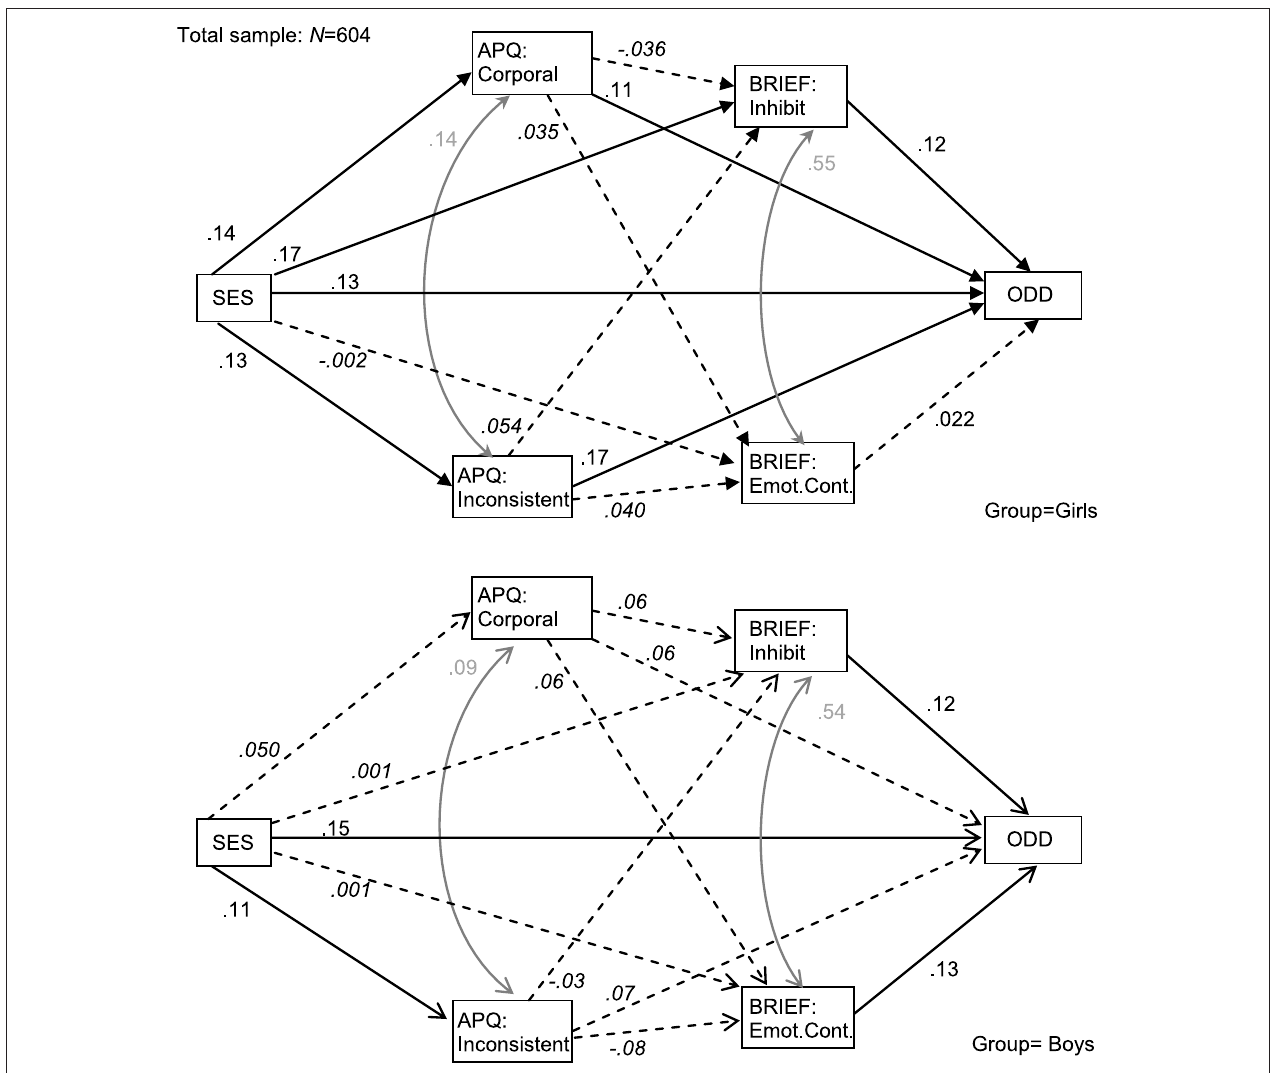
FIGURE 1 | SEM (adjusted by SDQ-ADHD score) including children’s gender as group variable. Discontinued-line and italics: non-significant associations. Attenuated line: inter-correlations between variables. SES, Socioeconomic Status; APQ, Alabama Parenting Questionnaire; BRIEF, Behavior Rating Inventory